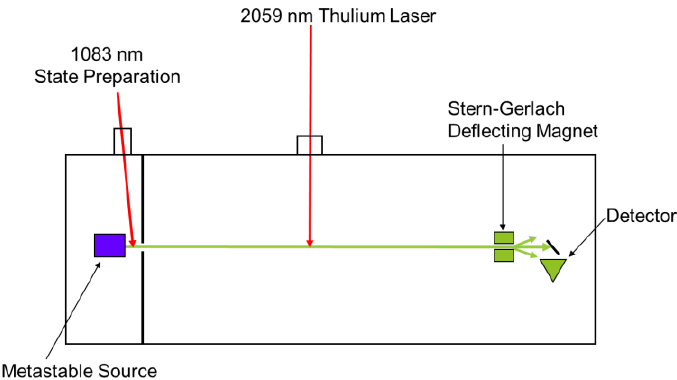
Figure 3. Helium Atomic Experiment.